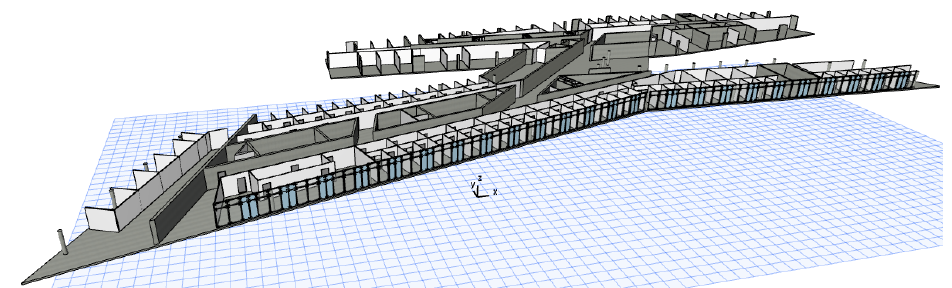
Figure 6. Model of the prototype environment.